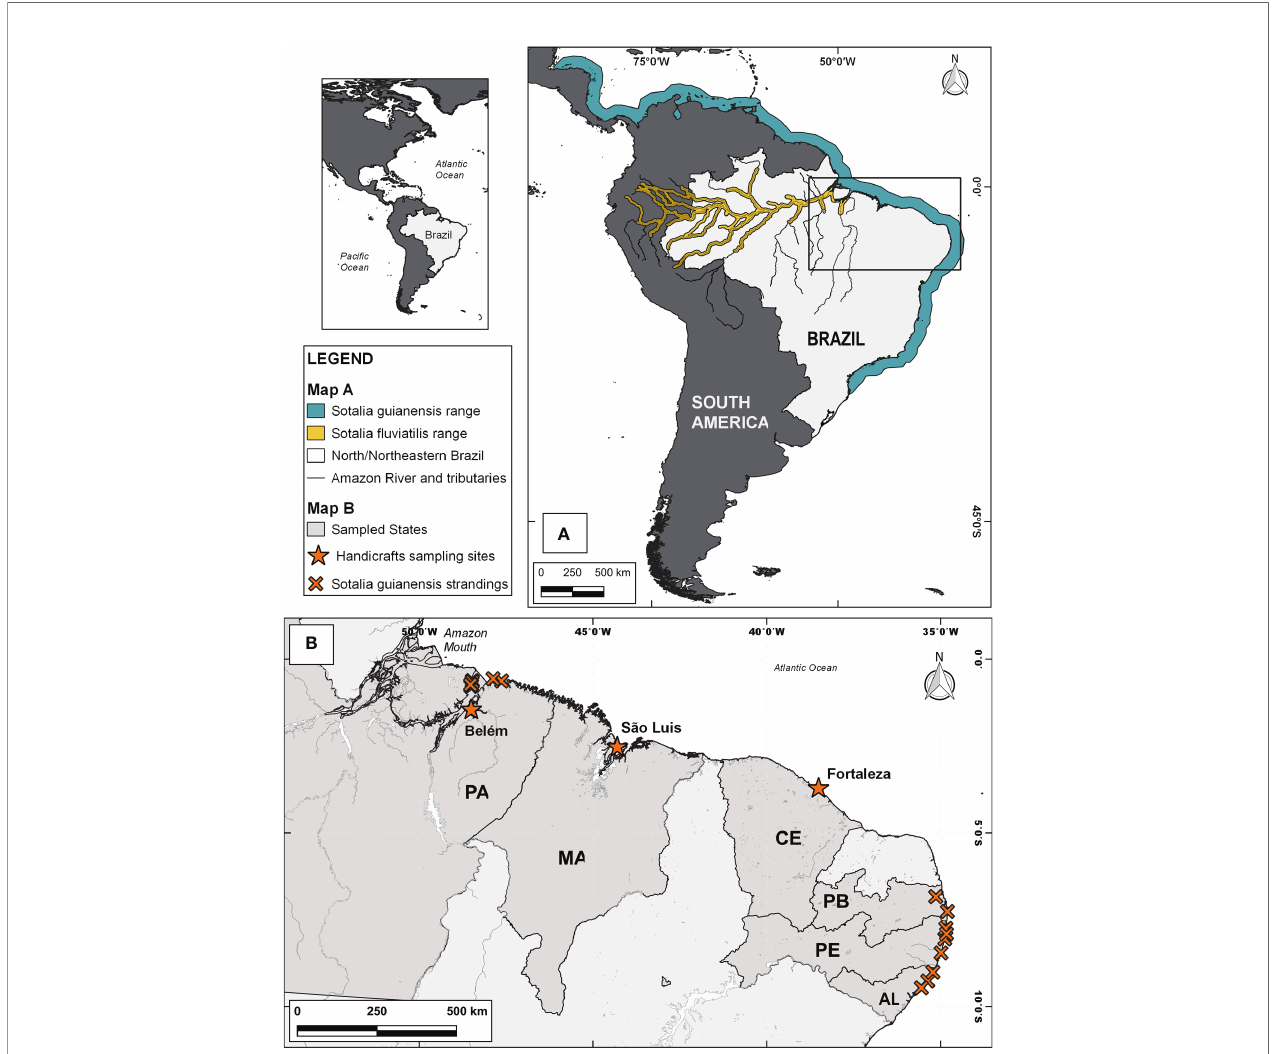
FIGURE 1 | Distribution range of the species from the genus Sotalia in South America (Map A ) and sampling points in the Northern (Map B : PA - Para ́ State), and Northeastern (Map B : MA - Maranhão State, and CE - Ceara ́ State, PB - Para ı ́ ba State, PE - Pernambuco State and AL - Alagoas State) regions of Brazil were handicrafts and stranded animals were collected. Distribution range data were extracted from NatureServe and IUCN